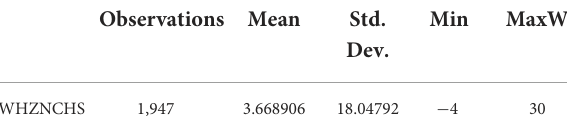
TABLE 4 Descriptive statistics of the outcome indicator-